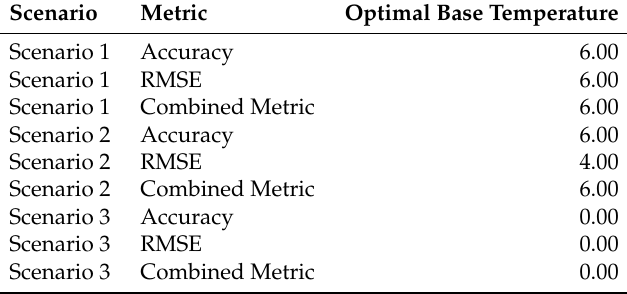
Figure 14. Base temperature optimisation for the scenarios described in Table 3: confidence intervals for Accuracy, RMSE, and combined metric. Table 4. Optimal values for the base temperature by metric for the scenarios described in Table